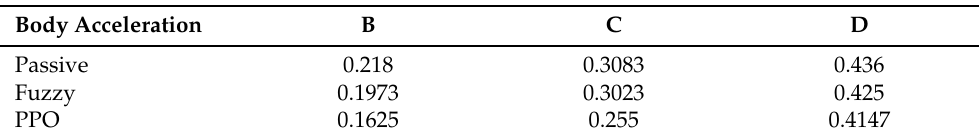
Figure 8. Body acceleration of fuzzy, PPO, and passive suspension systems for a heavy vehicle on class-B and -C roads. Table 8. The RMSE values of the two semi-active suspensions for a heavy vehicle under the same